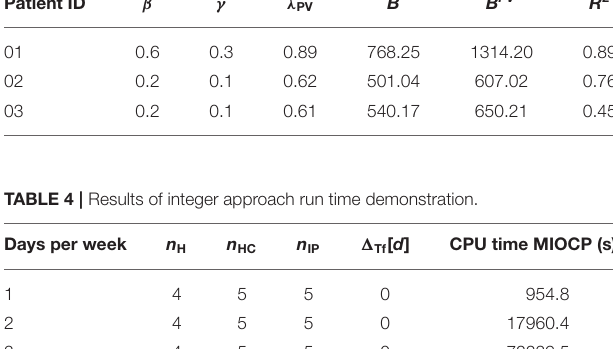
TABLE 3 | Results of proof-of-concept simulation of clinical data from three patients. Patient ID